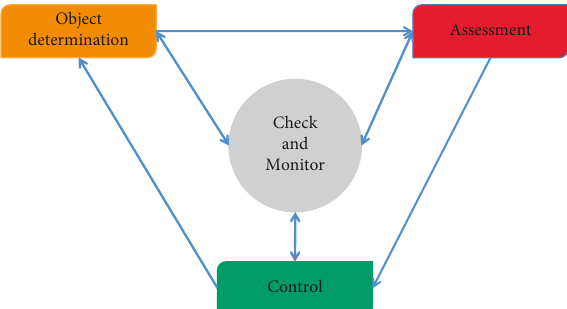
Figure 1: Flow chart of information security risk